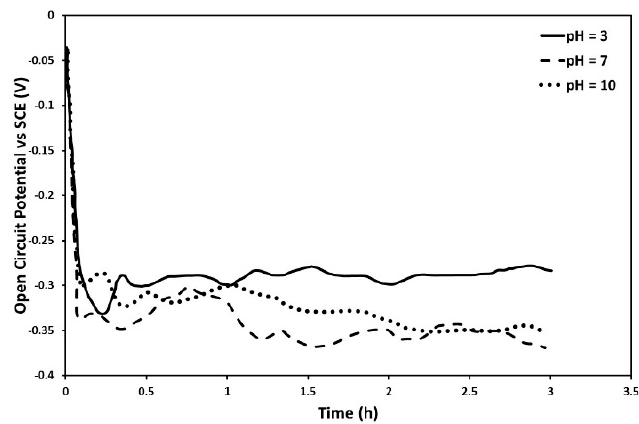
Figure 8. Effect of pH of 0.3 M NaCl solution on the open circuit potential (ocp) of T6 treated 6082 aluminum alloy as a function of immersion time. 6082 aluminum alloy as a function of immersion